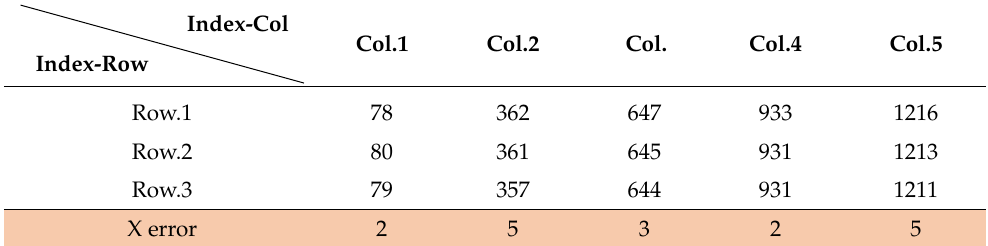
Table 2. Matching chip x -coordinate and x -coordinate deviation per column (unit: Pixel).